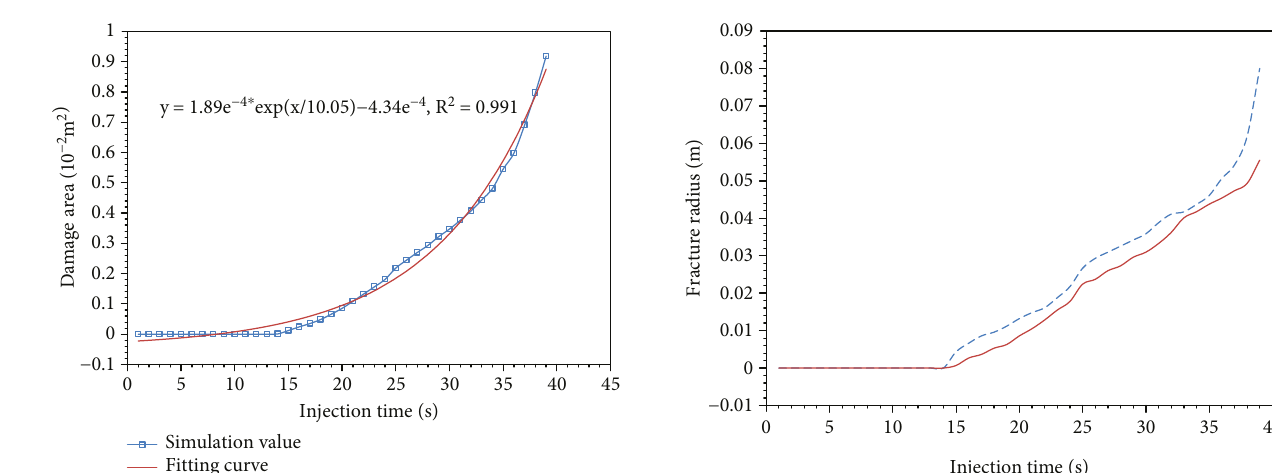
Figure 8: Distribution and evolution of the fracture in the layered jointed sample.